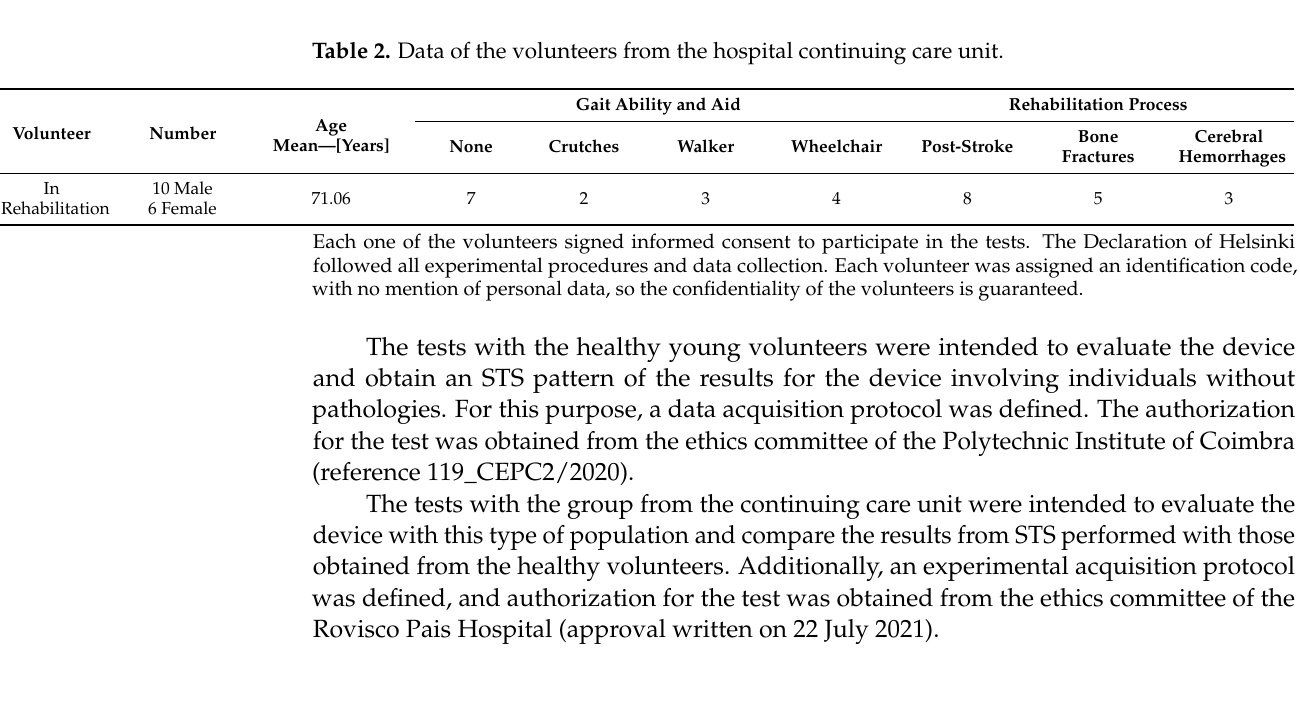
Figure 2. Experimental setup of the device (movable).